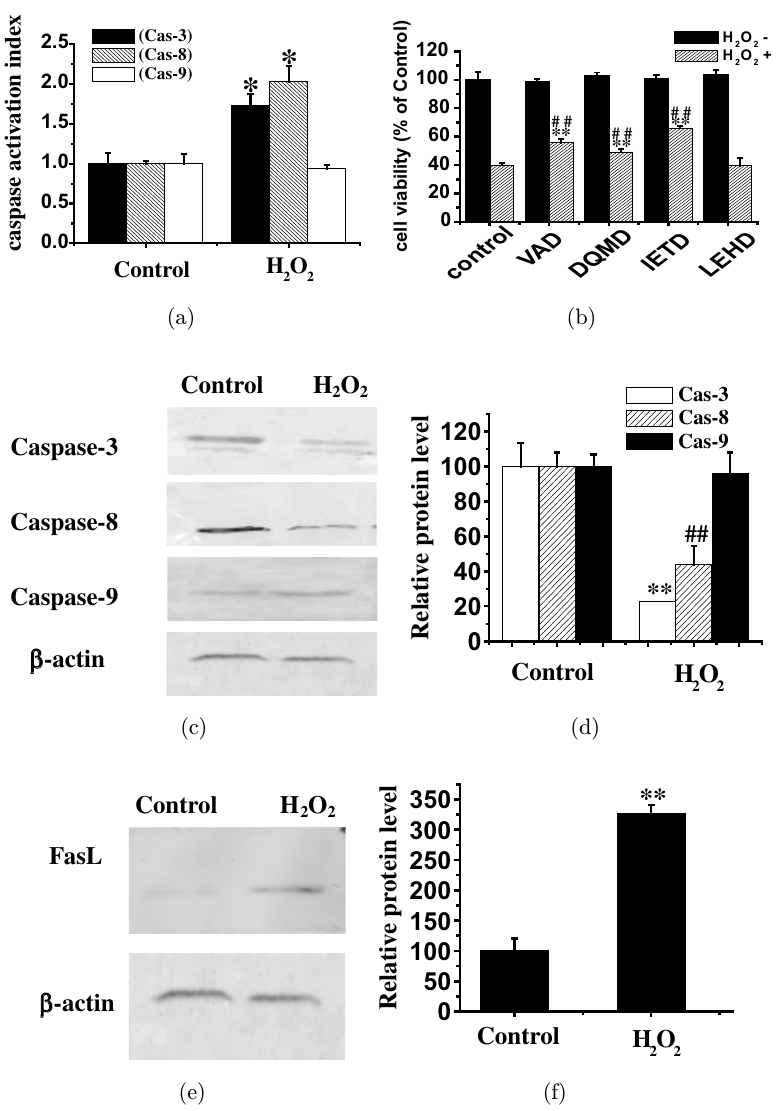
Fig. 3. Caspase-8 and -3 but not caspase-9 is involved in H 2 O 2 induced chondrocytes apoptosis. (a) H 2 O 2 treatment induced the activation of caspase-3 and -8 but not caspase-9 by °uorometric determination of caspase enzymatic activation. Data are mean (cid:4) SD ( n ¼ 3; ANOVA: * p < 0 : 05, compared with control cells). (b) H 2 O 2 -induced caspase-8- and -3-dependent cytotoxicity assessed by CCK-8 assay. Cells were treated with 0.3 mM H 2 O 2 for 2 h in the presence or absence of 5mM NAC, zVAD-fmk, zDQMD-fmk, zIETD-fmk and zLEHD-fmk, respectively. Data are mean (cid:4) SD ( n ¼ 3; ANOVA: ** p < 0 : 01, compared with blank control cells; # p < 0 : 05 and ## p < 0 : 01, compared with the H 2 O 2 -treated cells). (c) Western Blotting analysis of the expression levels of caspase-3, -8 and -9 for the control and H 2 O 2 -treated cells. (d) Quantitative analysis of caspase-3, -8 and -9 levels. Data are mean (cid:4) SD ( n ¼ 3; ANOVA: ** p < 0 : 01, ## p < 0 : 01, compared with control cells). (e) H 2 O 2 potently up-regulated the expression level of FasL determined by Western blotting analysis. (cid:1) -actin served as the loading control. (f) Quantitative analysis of FasL level. Data are mean (cid:4) SD ( n ¼ 3; ANOVA: ** p < 0 : 01, compared with control